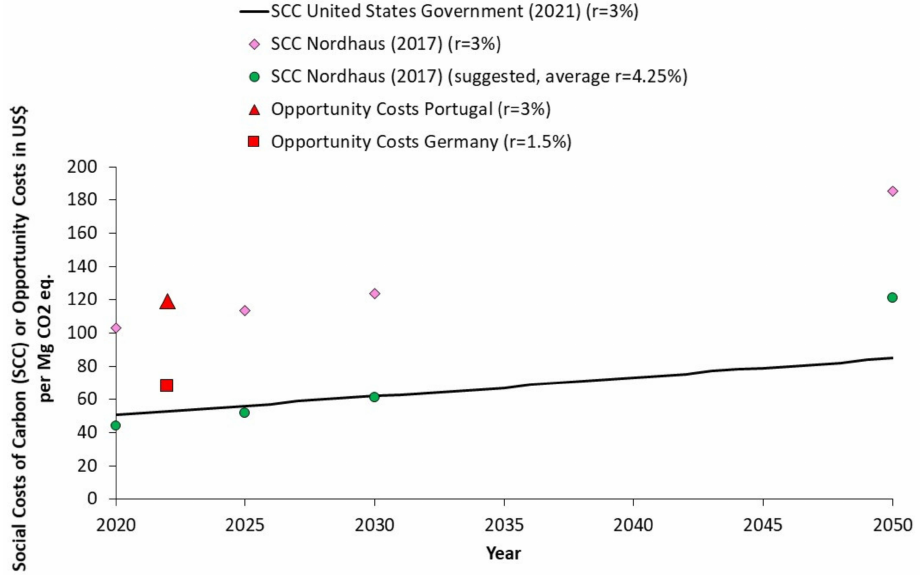
Figure 2. Comparison of forest owner’s opportunity costs with published social costs of carbon (SCC). We used SCC published by United States Government [45] and Nordhaus [39]. SCC adopted from Nordhaus [39] were converted from 2010 to 2020 USD by the factor of 1.181789822 [43] and opportunity costs in EUR into USD by the factor of 1.04. r is the discount